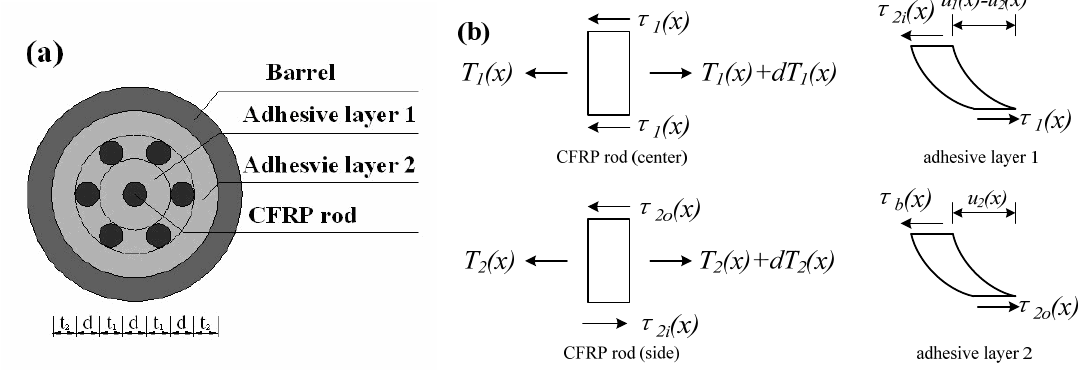
Figure 3. ( a ) Cross-section of a multi-rod anchor; ( b ) stress state of a multi-rod